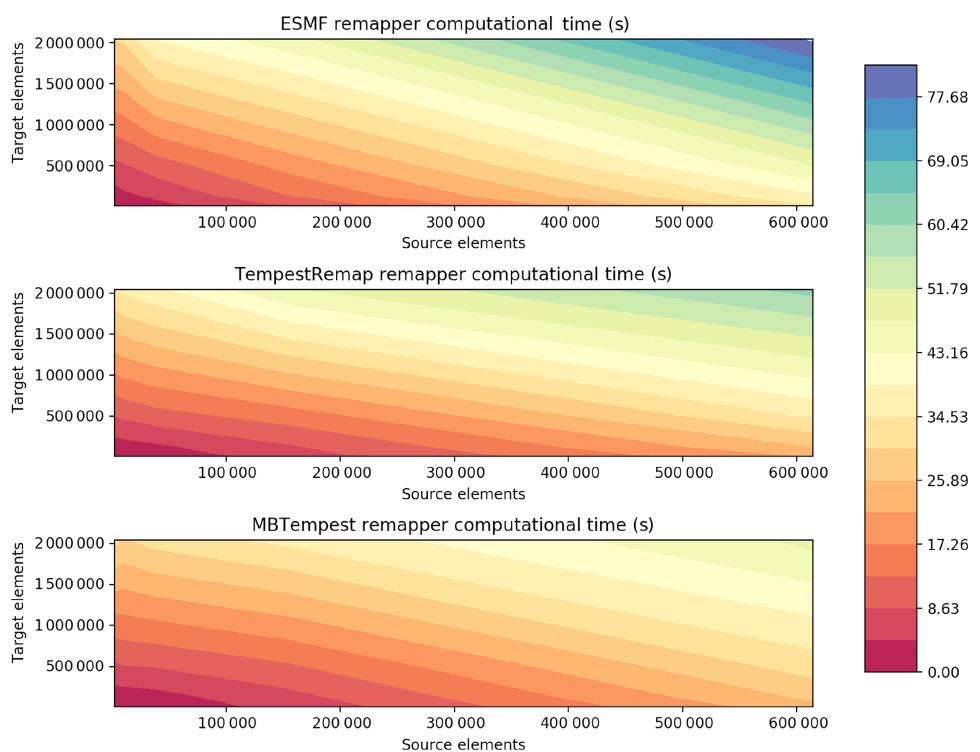
Figure 8. Comparison of serial regridding computation (supermesh and projection weight generation) between ESMF, TempestRemap, and